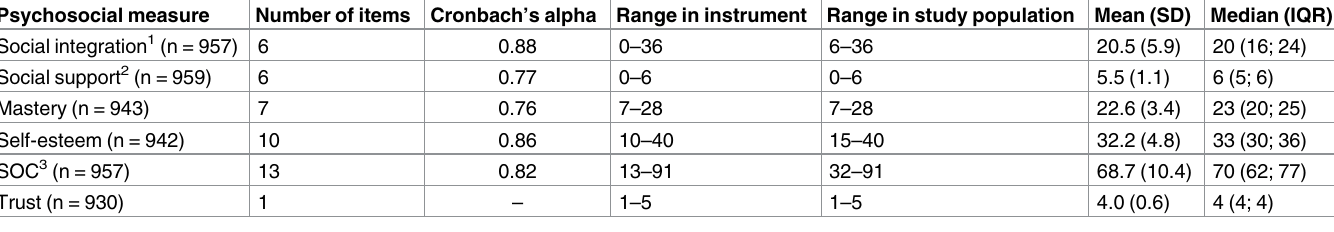
Table 2. Characteristics of psychosocial resources in the study population.